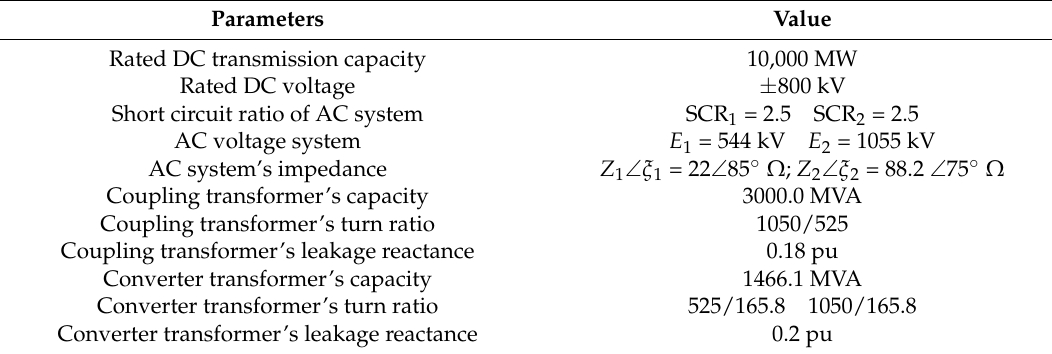
Table A1. Parameter Specifications of the UHVDC-HCS System.